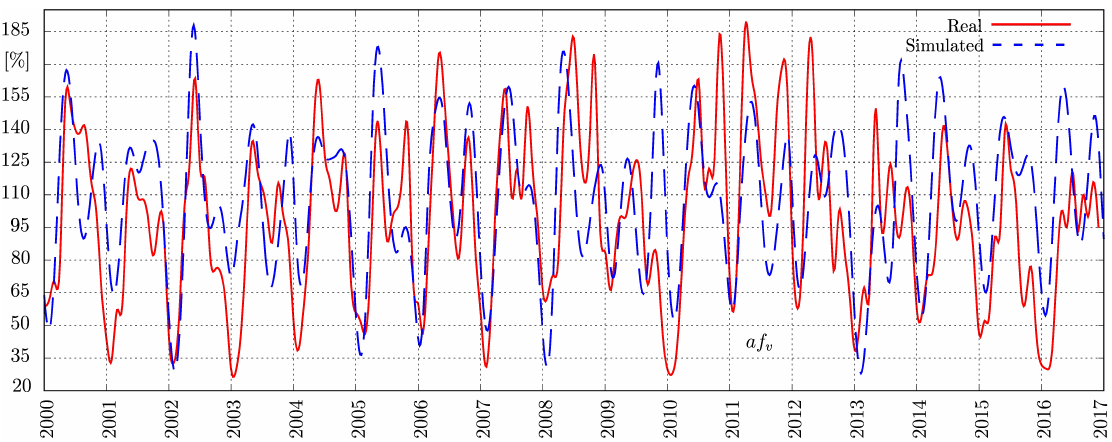
Figure 6. af v . The red signal represents the real behavior of the aggregate flow series of Colombian rivers obtained from [24]. The blue signal is computed by the author using Equations (1) and (2). The MAPE (mean absolute percentage error) = 11.35